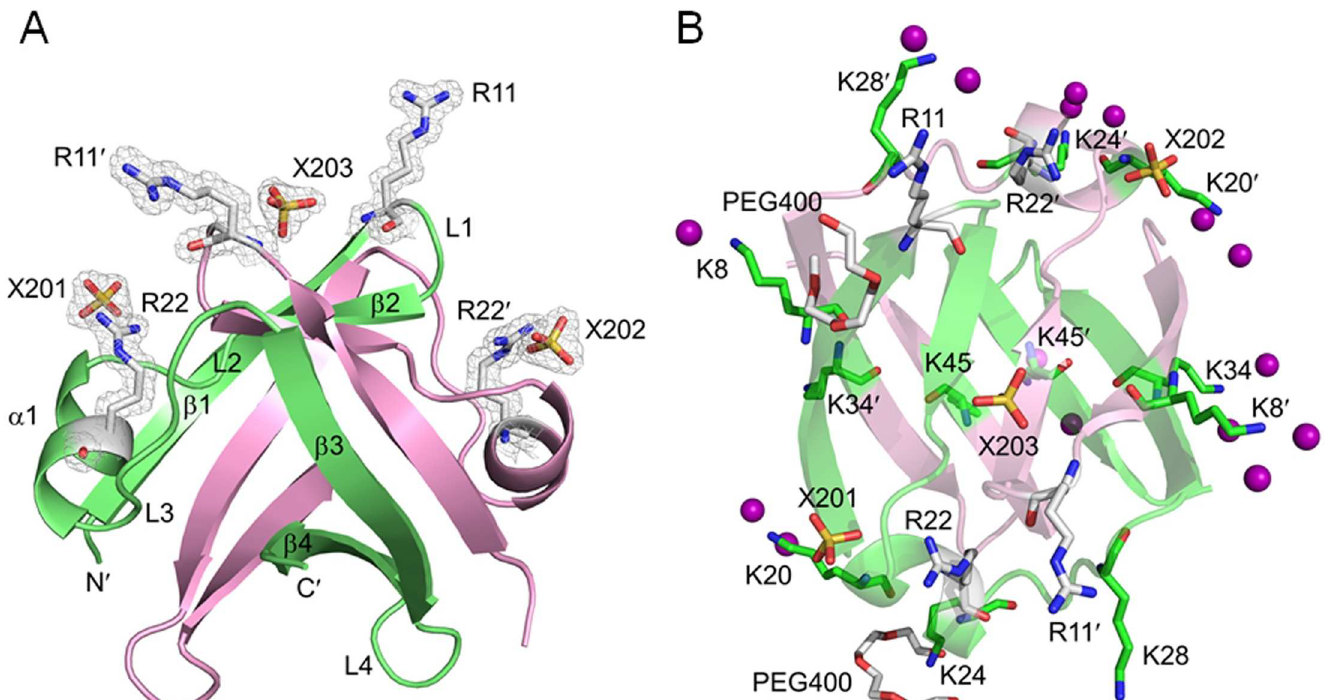
Fig 1. Crystal structure of the wild-type Sso7c4 protein. (A) Ribbondiagram of wild-typeSso7c4 with the two argininepairs (R11/R22 0 and R11 0 /R22) and three sulfates (X201, X202 and X203) depictedas balls and sticks with (2 F o- F c)Fourier electrondensity maps (contoured at 1 σ level). (B) Top view of the Sso7c4 dimer. The ribbondiagramsof the Sso7c4 dimer are colored green and pink to represent each monomer. All the lysine residues,the two argininepairs, the three sulfates and the two PEG 400 moleculesare depicted as balls and sticks. The water moleculessurroundingthe lysine side chains are drawn as